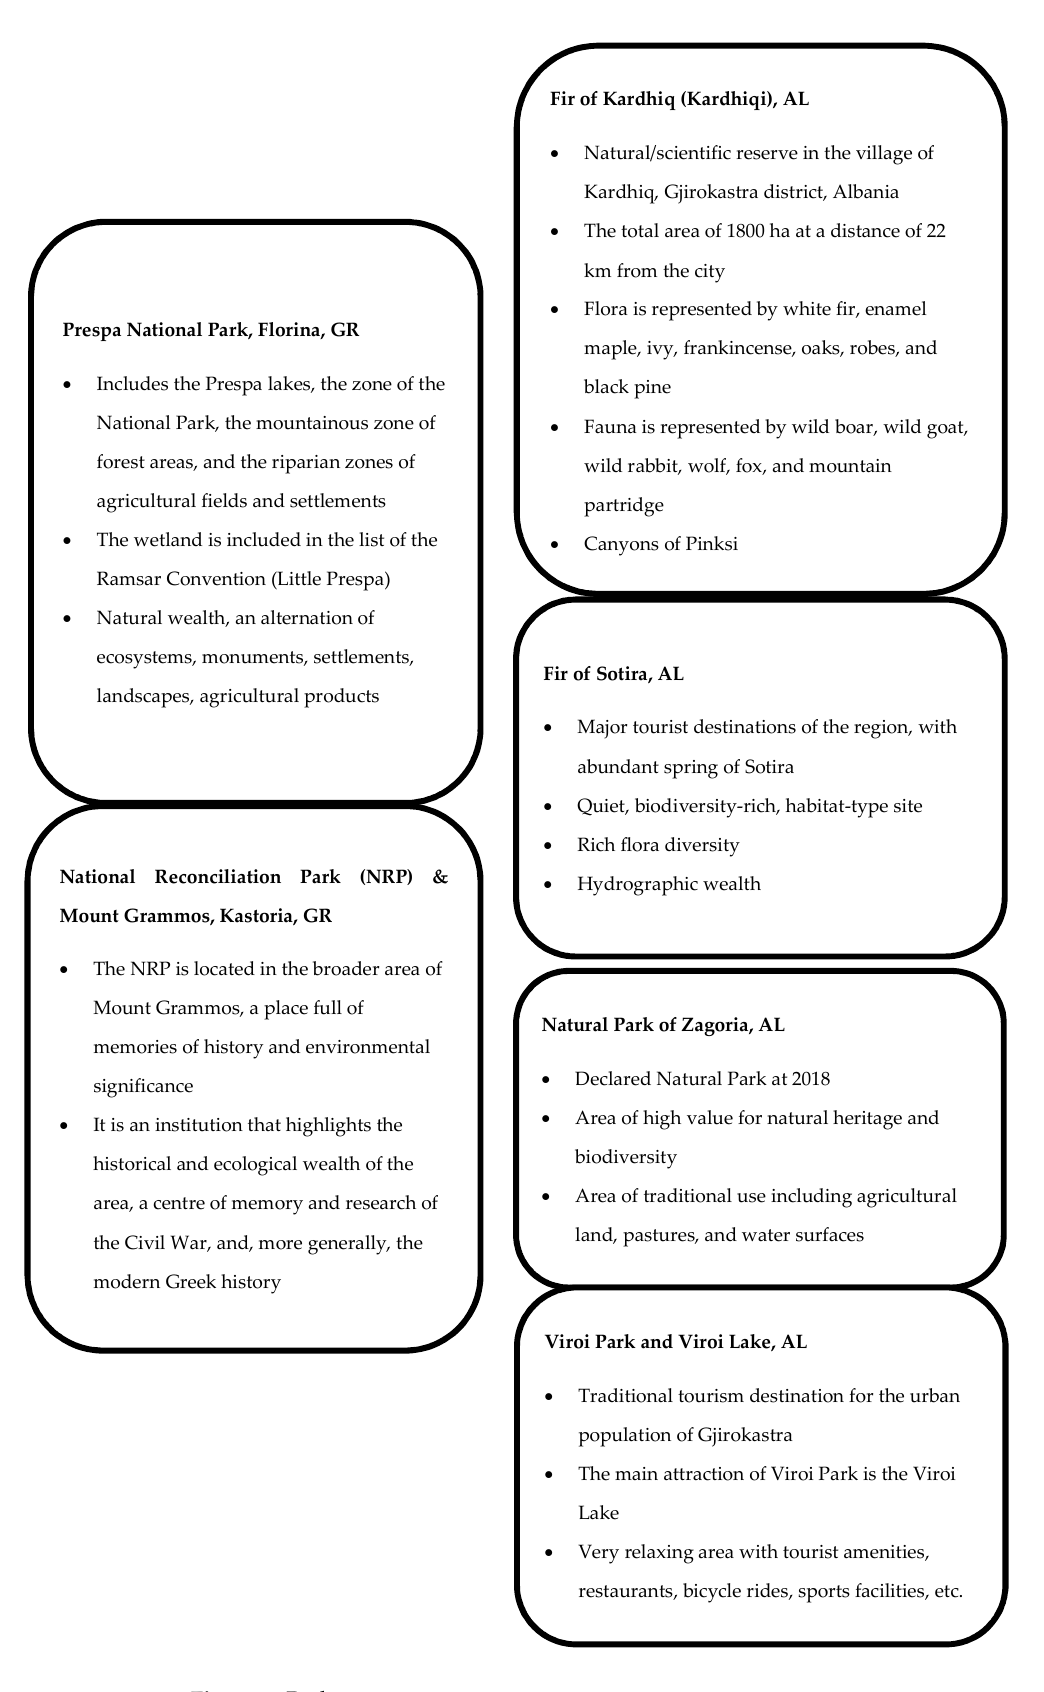
Figure 3. Parks. Figure 3.